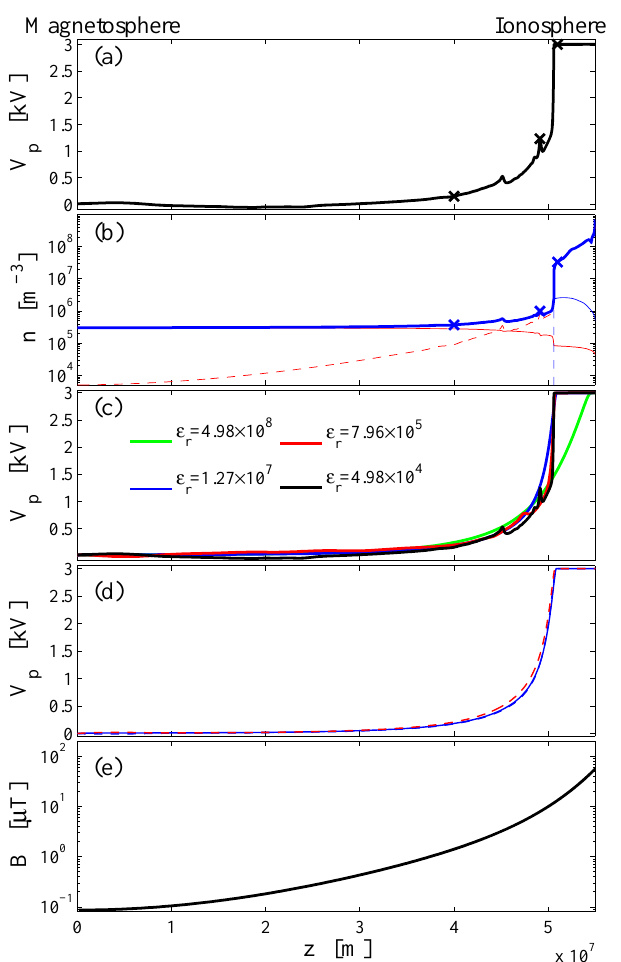
Fig. 3. (a) Plasma potential as a function of z . (b) The density in the same simulation. The thick blue curve shows the plasma density. The thin solid curves show protons (red) and electrons (blue) from the magnetospheric end of the system. The dashed curves show pro- tons (red) and electrons (blue) originating from the ionosphere. The Xs indicate the positions for which distribution functions are shown in Fig. 6. (c) Potential profiles for different values of (cid:15) r . (d) Test of the influence of the initialisation process. The dashed blue curve shows the potential after the system was filled at (cid:15) r = 1 . 27 × 10 7 . The dashed red curve shows the potential after the system was first filled at zero voltage, and then the voltage was ramped up to 3kV, also at (cid:15) r = 1 . 27 × 10 7 . The solid blue curve is the corresponding potential profile copied from panel (c) . The solid and dashed blue curves overlap almost completely. (e) Magnetic flux density B , as given by Eq. (36).